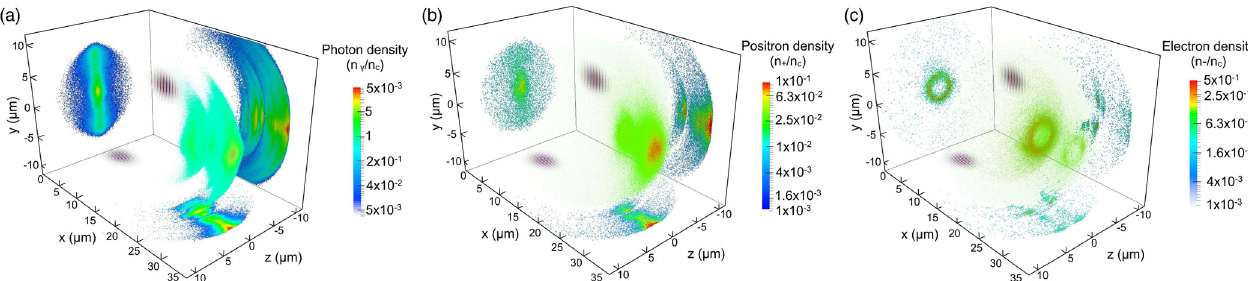
FIG. 4. 3D density distributions of the photons (a) positrons (b) and electrons (both from the primary beam and the nonlinear Breit-Wheeler process) (c) at the end of the laser interaction. Density slices along the x ¼ 27 . 5 μ m (corresponding to the densest part of the beam head), y ¼ 0 and z ¼ 0 planes are projected onto the yz , xz and xy domain boundaries, respectively. The leftward-moving laser pulse is visualized by its normalized electric field, eE y =m e c ω 0 , projected on the domain boundaries (blue and red colors near x ¼ 5 μ m). Animations of these density distributions can be watched in the Supplemental Material [50].